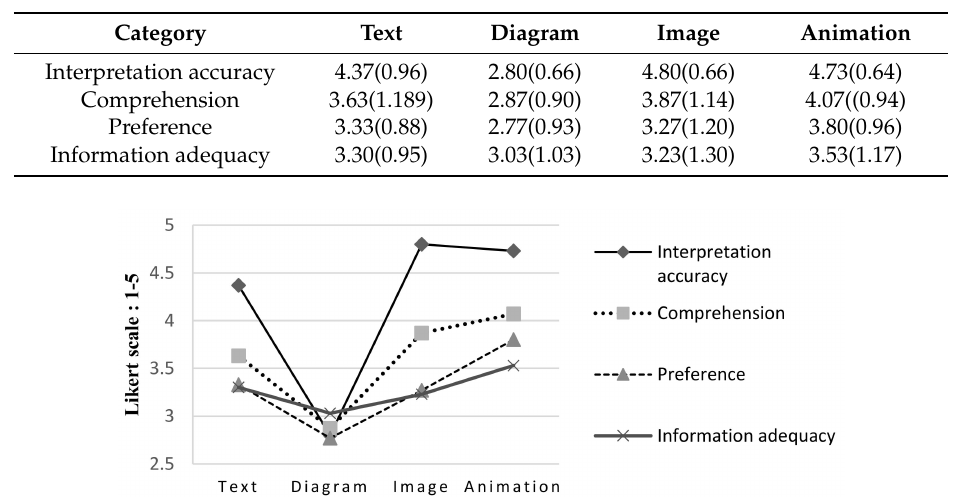
Table 5. Average mean and standard deviation values for interpretation accuracy, comprehension, preference, and information adequacy (standard deviation in parentheses; unit: points; five-point Likert scale).